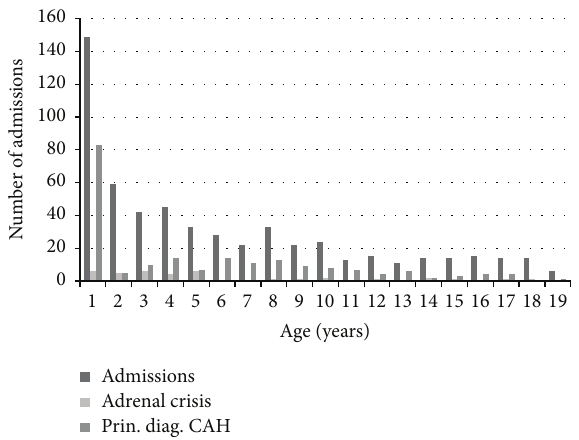
Figure 1: Total admissions, admissions for principal diagnosis of CAH, and admissions with an adrenal crisis in patients with CAH, NSW,